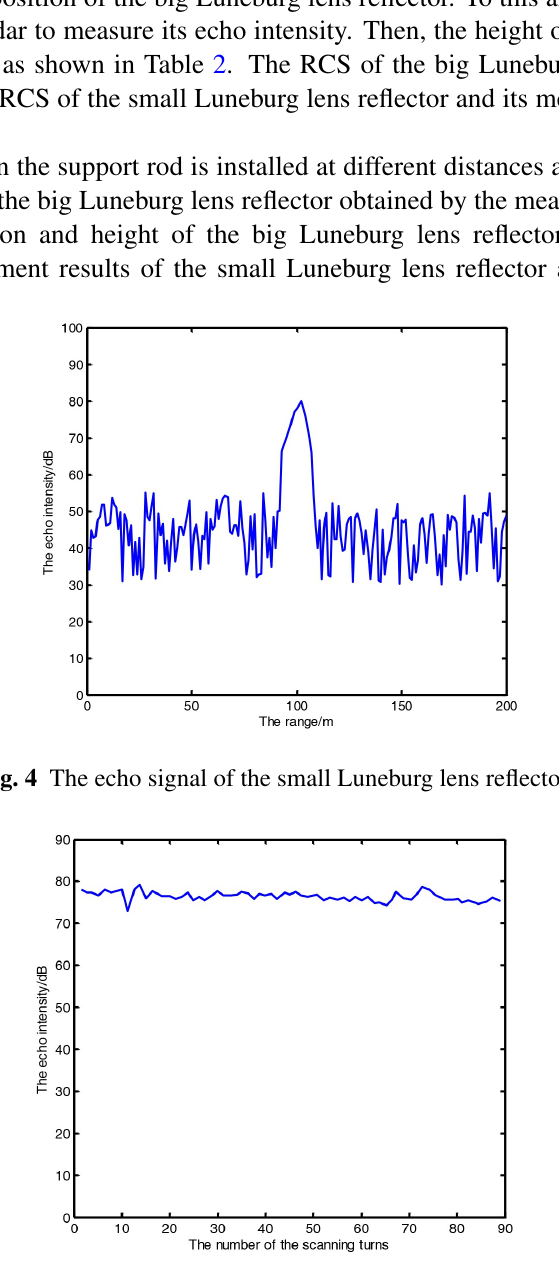
Fig. 5 The echo intensity of the small Luneburg lens